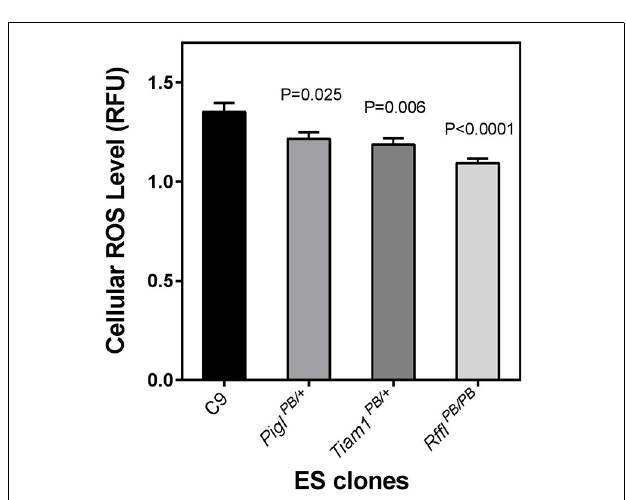
exhibit stronger stress resistance compared to the heterozygotes. Resistance to both stressors was lost when the PB insertions were removed ( + / + : light gray). Error bars represent SD of mean ( n = 4). ∗ p < 0 . 001, # p = 0 . 01 between the gene-trap clones and the wild-type parental C9, evaluated by Student’s t -test. (C) ES cell colonies formation under PQ (10 μ M) treatment. Stress-resistant ES clones were able to form colonies in culture under PQ treatment while the number and size of colonies from the wild-type clone were significantly reduced.